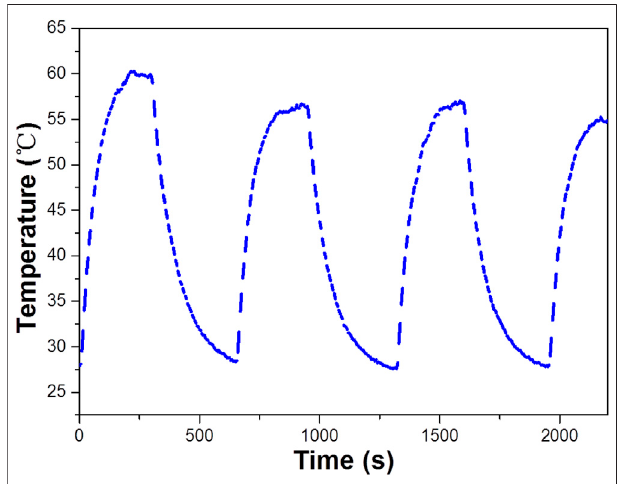
FIGURE 5 | UV – vis absorbence spectrum for the aqueous dispersion of the WO 3 NPs under visible light (concentration 100